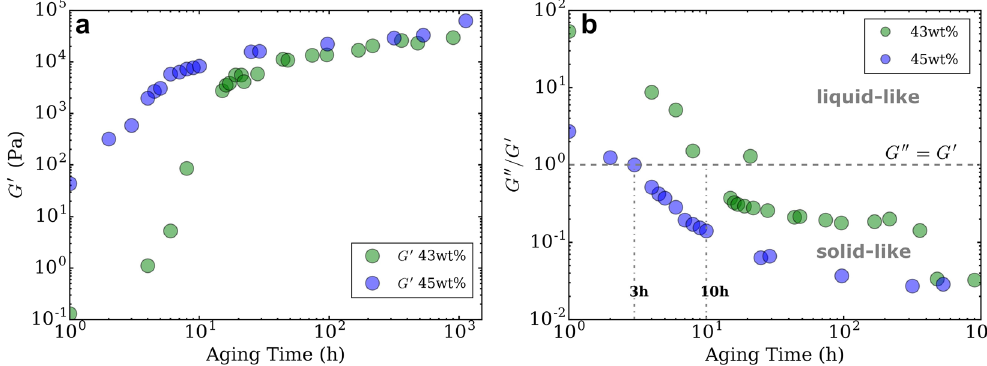
Figure 3. ( a ) Evolution of elastic modulus G ′ for 43 and 45 wt% suspensions measured at 1 Hz ( b ) Evolution of G ′′ / G ′ as a function of aging time for 43 and 45 wt% solids loading.